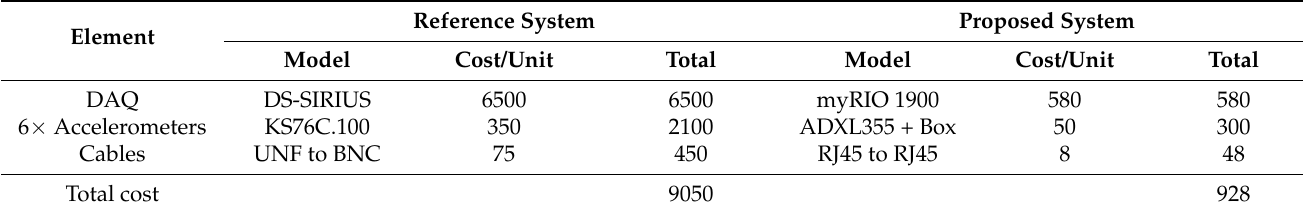
Table 2. Estimated cost (€) of the reference and proposed systems.